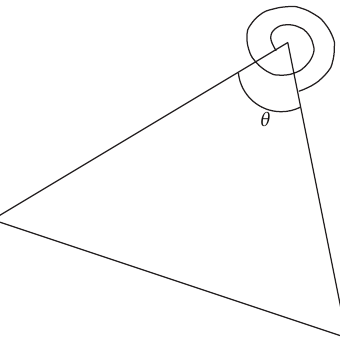
Figure 13: Torsional